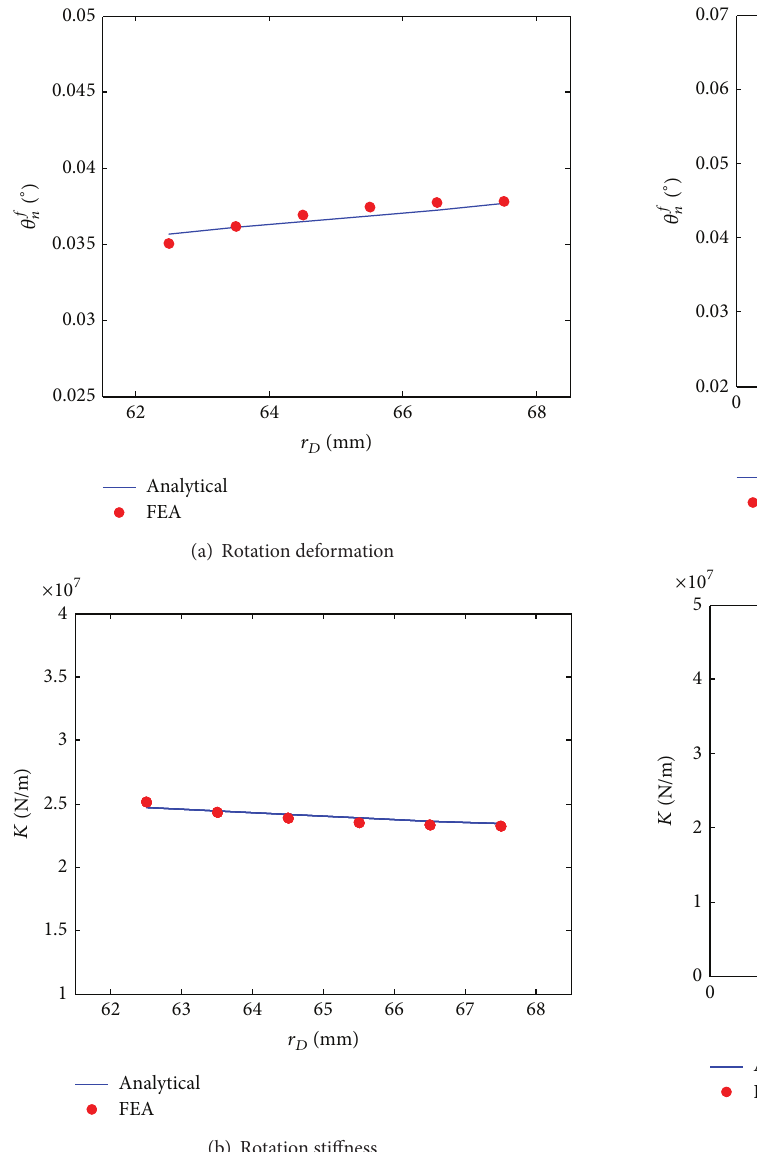
Figure 8: Rotation stiffness and deformation of nut flank with variation of 𝑟 𝐷 .